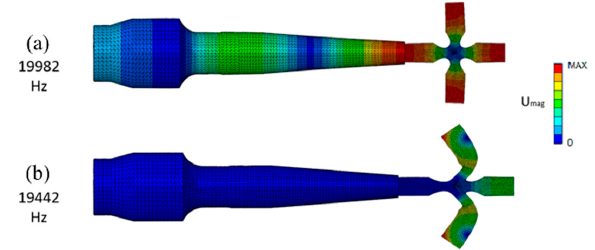
Figure 29. Assembly of specimen and horn in free-free vibration: ( a ) T-T mode shape; ( b ) Flapping mode shape [24].